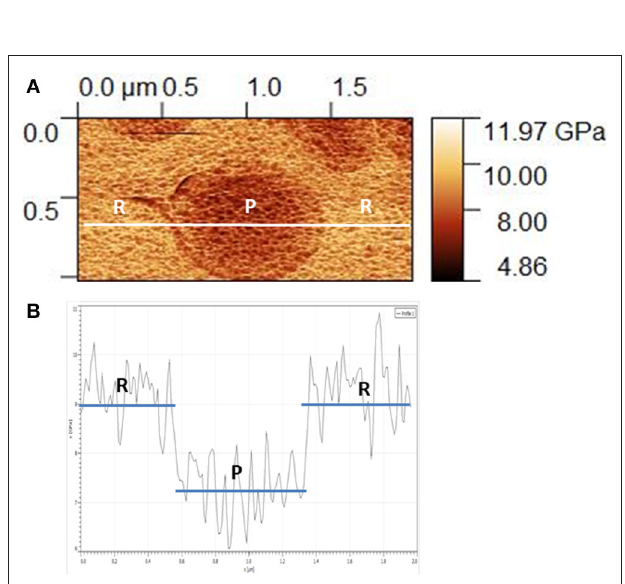
FIGURE 3 | (A) Detailed mapping of indentation modulus for the Ag 20 (Ge 0.25 Se 0.75 ) 80 glass and (B) variation of the indentation modulus along the profile drawn in (A) . In both images, “R” and “P” correspond to R-Agx and P-Agx phases, respectively.